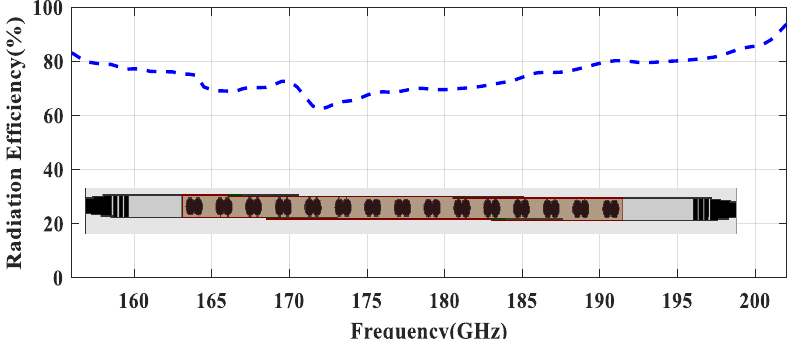
Figure 7. Simulated radiation efficiency versus frequency. Table 1. Performance comparison with the prior literature. Figure 6. Simulated main beam angles and gain versus frequency.